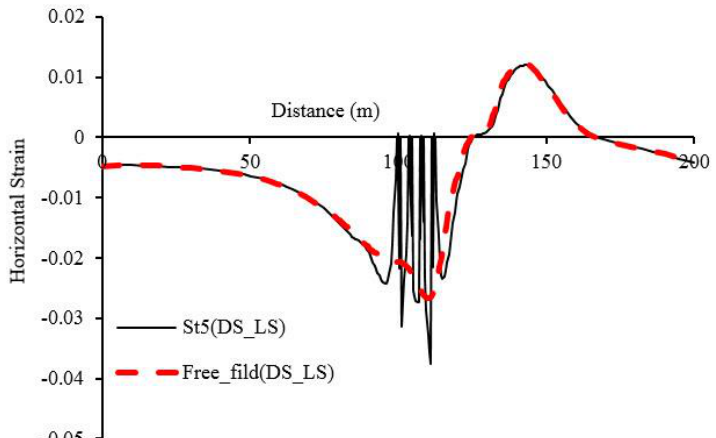
Fig. 20. Horizontal strain of ground with and without structure for 5 floor building with single foundation and with DS-LS density.